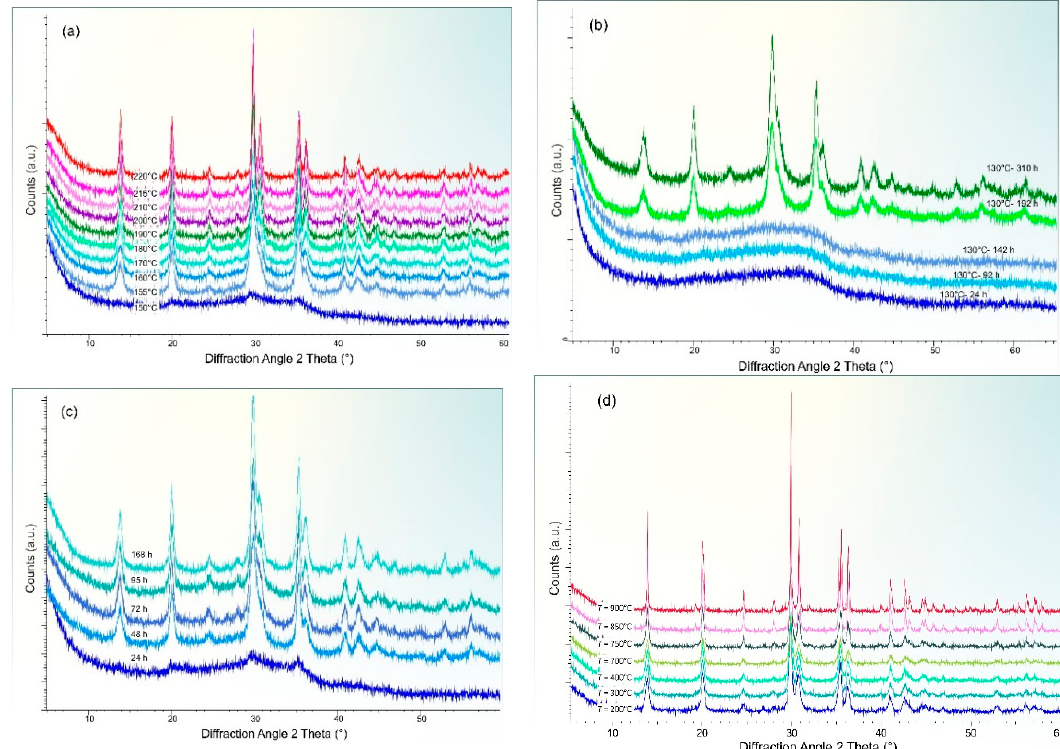
Figure 3. X-ray powder diffraction pattern of aegirine NaFeSi 2 O 6 for different series of synthesis and thermal treatment: ( a ) variation of synthesis temperature at fixed synthesis time of 24 h, ( b ) variation in synthesis time at 130 °C, ( c ) variation in synthesis time at 150 °C and ( d ) effect of additional heat treatment at different temperatures on the sample, obtained at 200 °C/24 h.